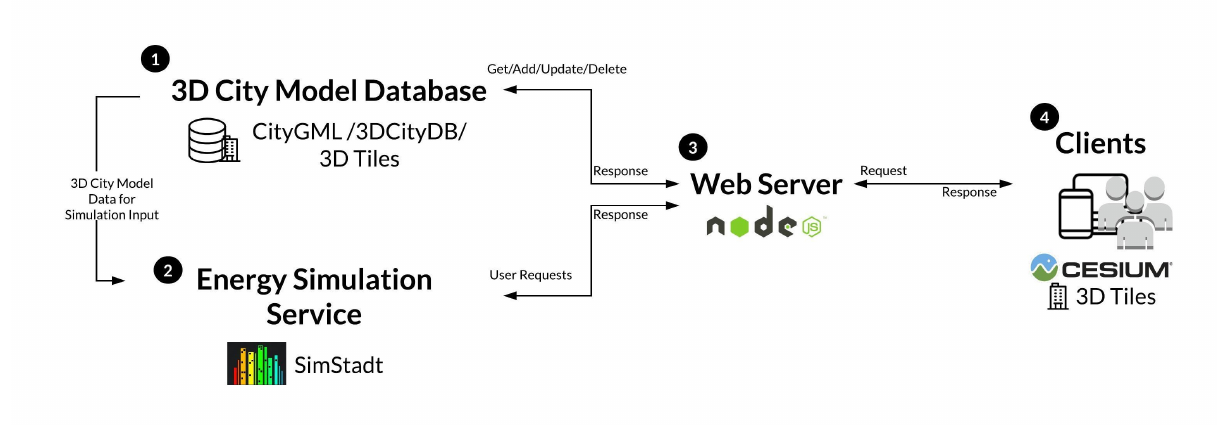
Figure 4. The overall system architecture of CitySourcing platform.